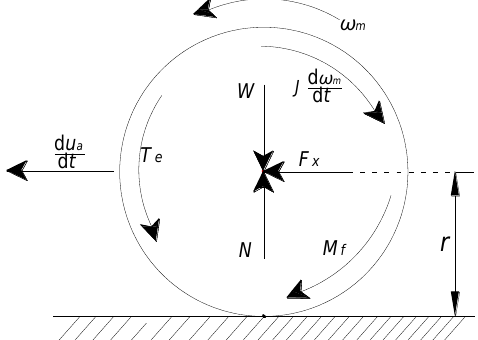
Figure 3. Electric wheel model during acceleration. u a is the forward speed of the wheel; W is the total weight of electric wheel and its load; N is the supporting force.